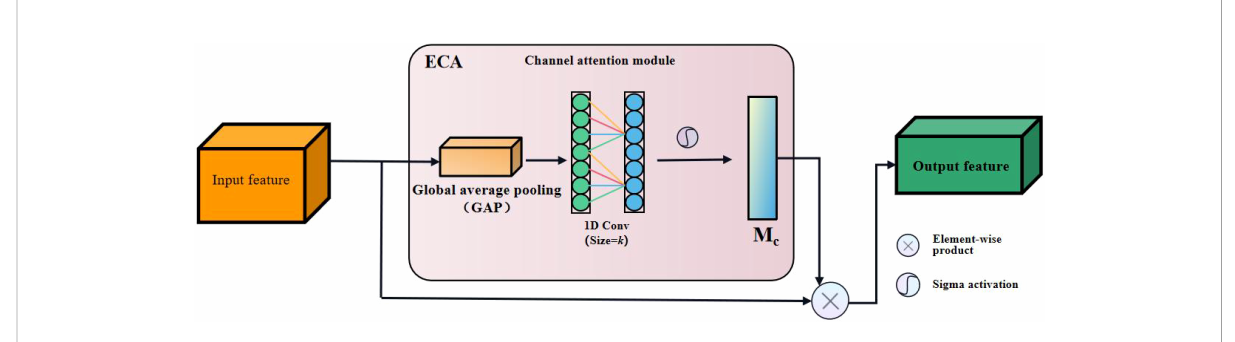
FIGURE 8 Structure diagram of the Ef fi cient Channel Attention (ECA)